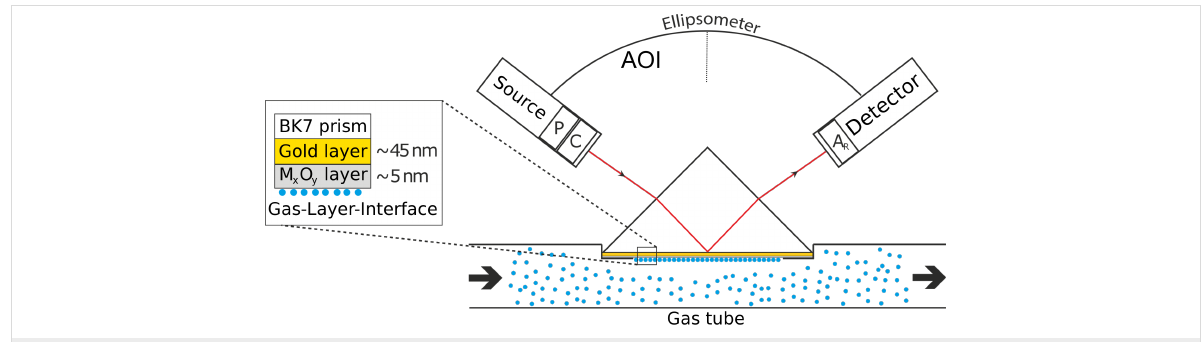
Figure 1: Scheme of the SPREE gas sensing device.